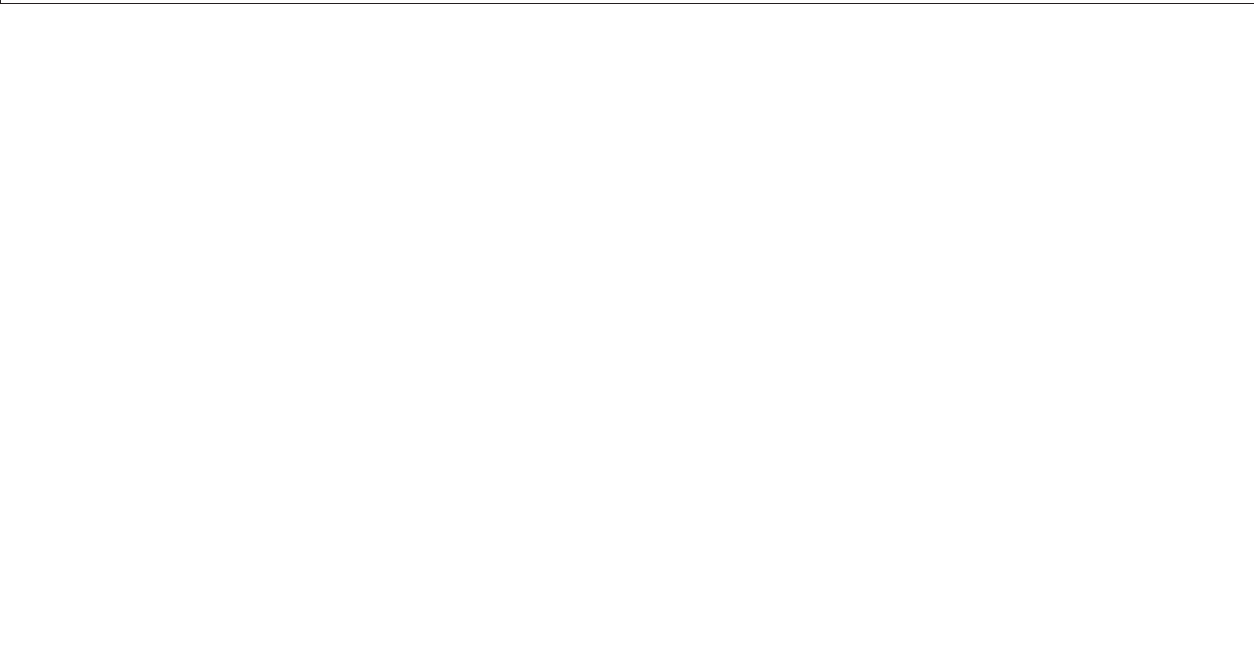
Frontiers in Systems Neuroscience